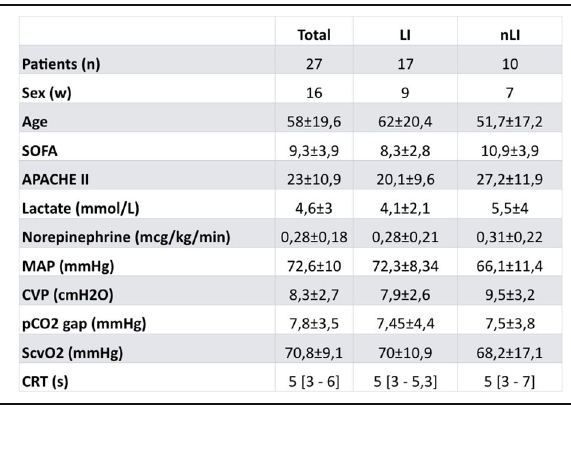
Table 1 (abstract 000305). Basal demographic and hemodynamic characteristics at inclusion